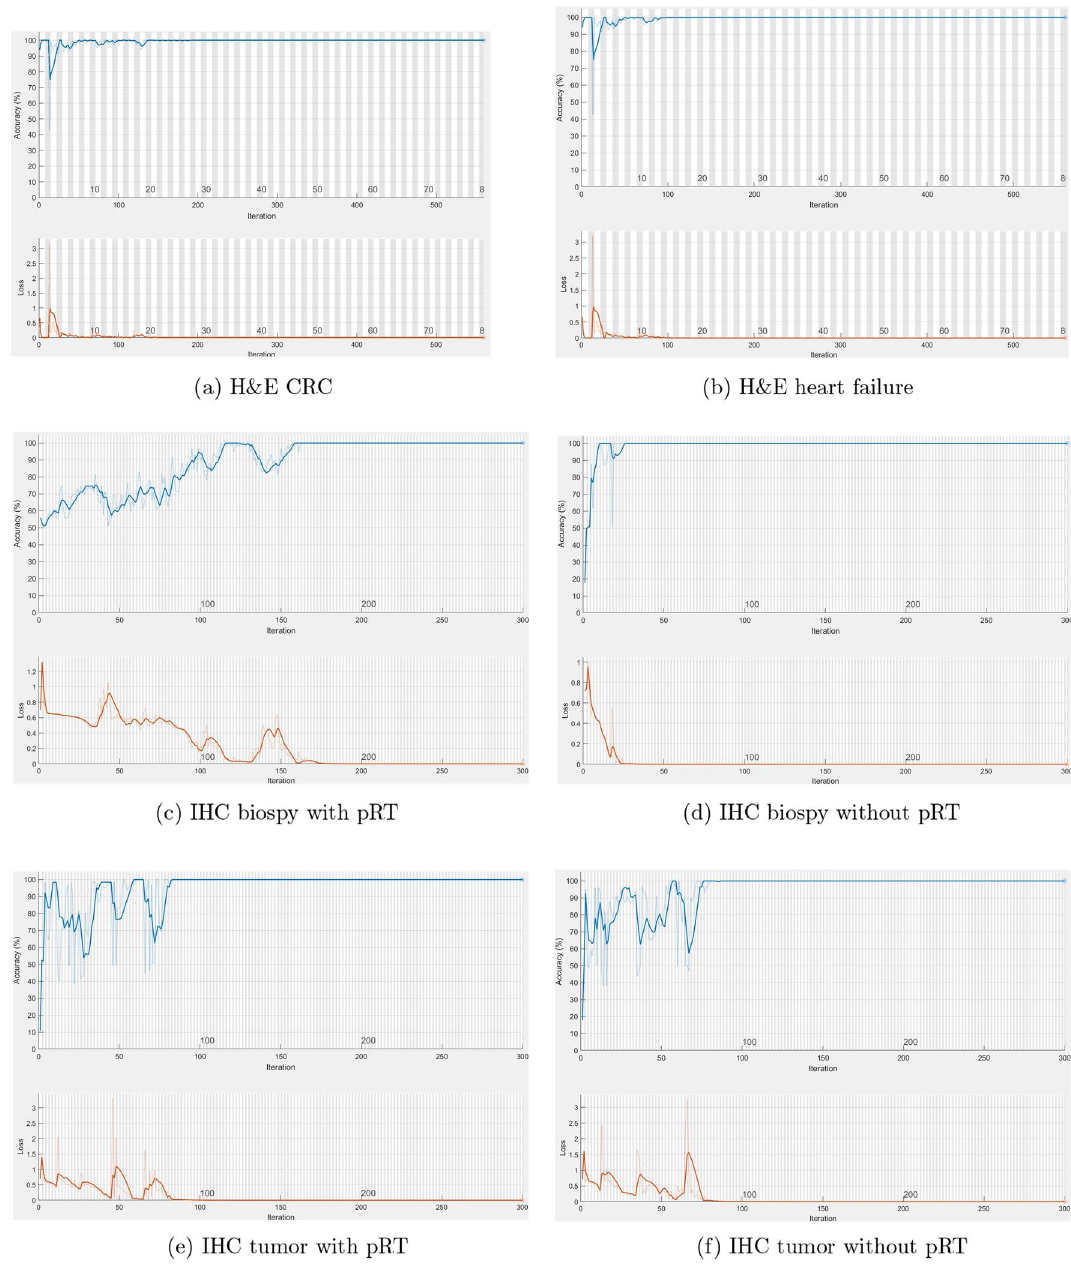
Figure 8. Plots of image-LSTM training progresses using different